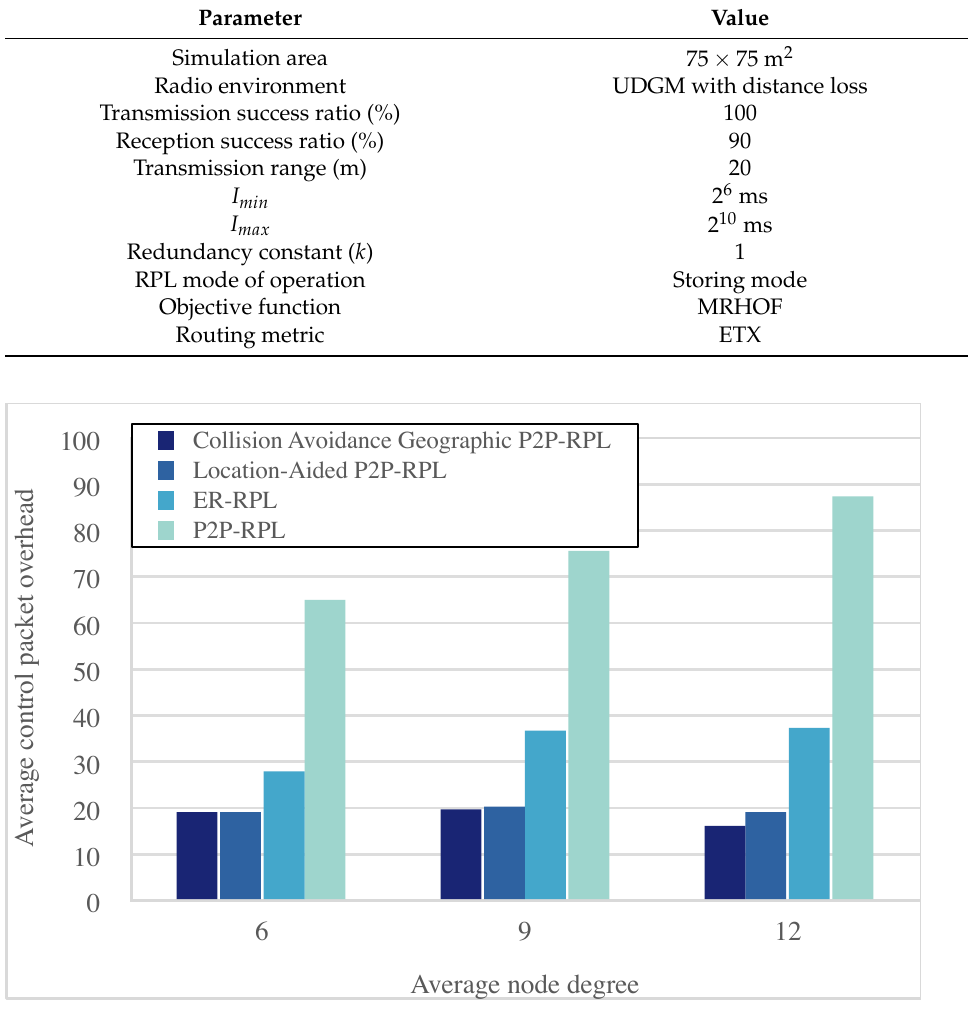
Figure 8. Average control packet overhead versus average node